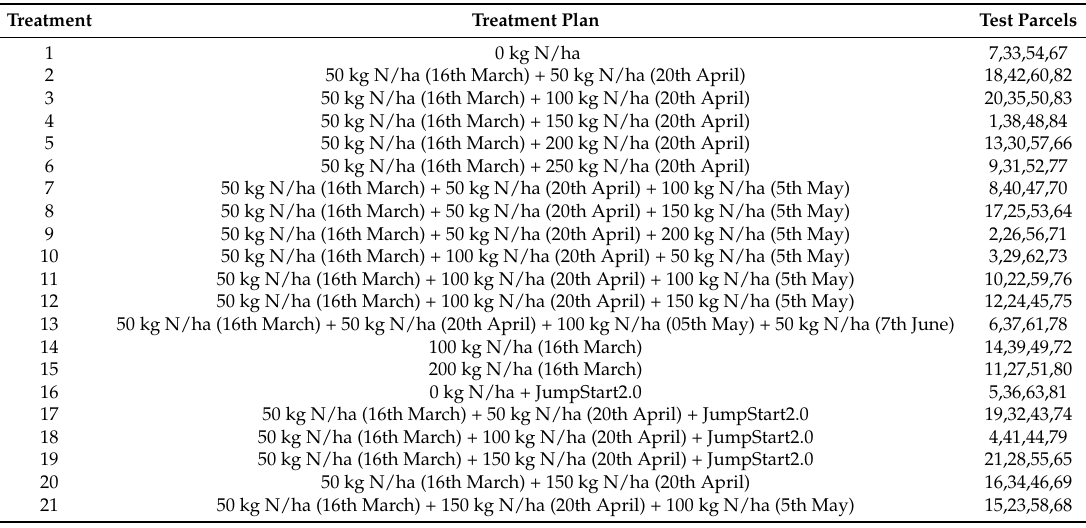
Table A1. Treatment plan for winter wheat test parcels in the experimental field. Treatment